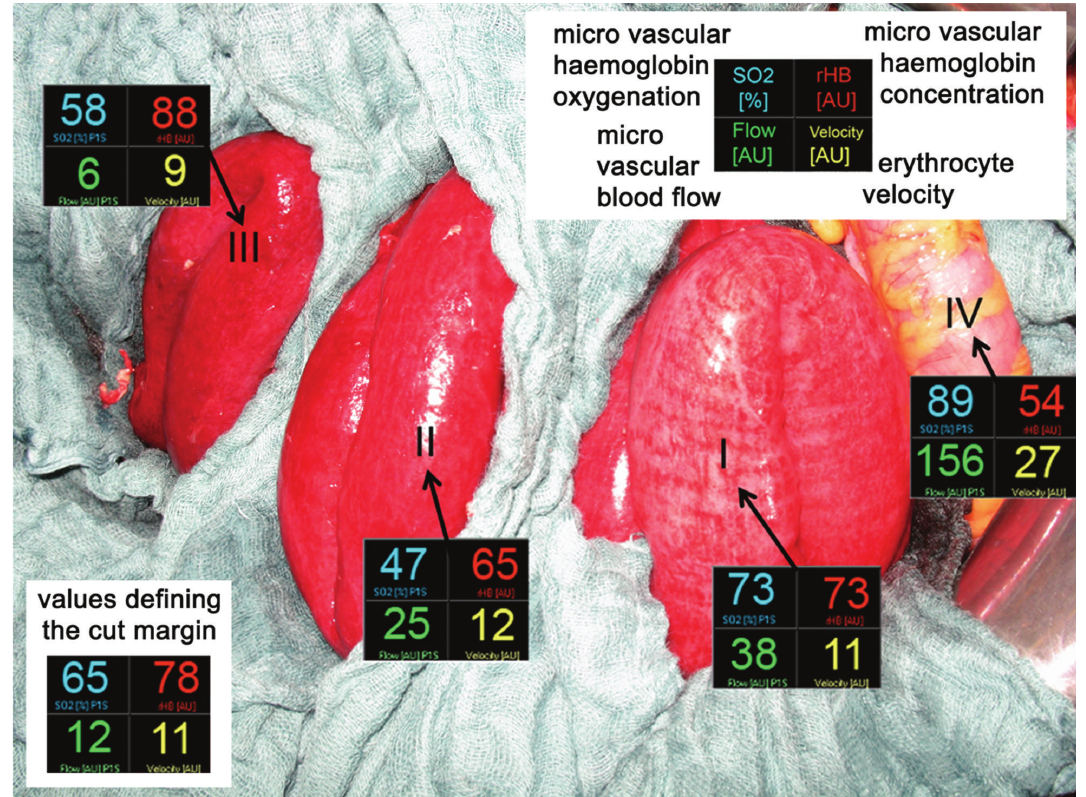
Figure 2: Mean values (10sec) of laser Doppler flowmetry (microvascular flow and erythrocyte velocity) and spectroscopy (microvascular haemoglobin oxygenation SO 2 and microvascular haemoglobin concentration rHB) of the proximal segment of the jejunum (I), of the distal segment of the jejunum and the ileum (II and III), and of the transverse colon (IV). The mean values measured at the chosen cut margin are just in range of the critical threshold values. The resected segment of bowel (III) shows a microvascular flow value below the critical threshold value of 10AU and a microvascular haemoglobin concentration rHB almost at the critical threshold value of 90